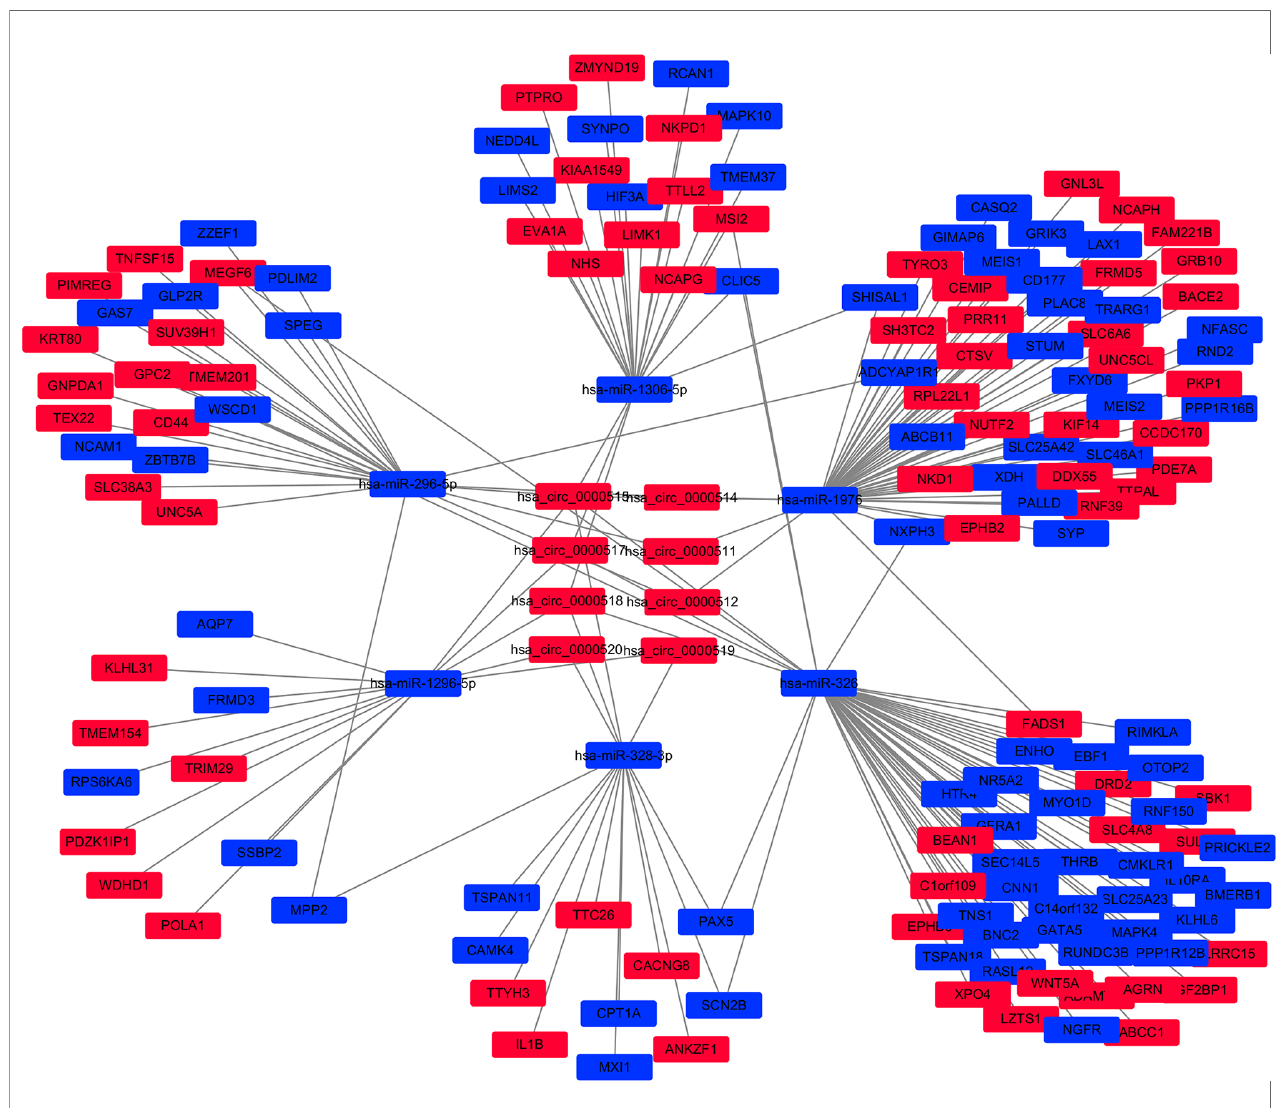
FIGURE 3 | The circular RNA (circRNA) – miRNA – mRNA network in the colorectal cancer (CRC) by Cytoscape v3.6.0. The red and blue nodes represent upregulation and downregulation,